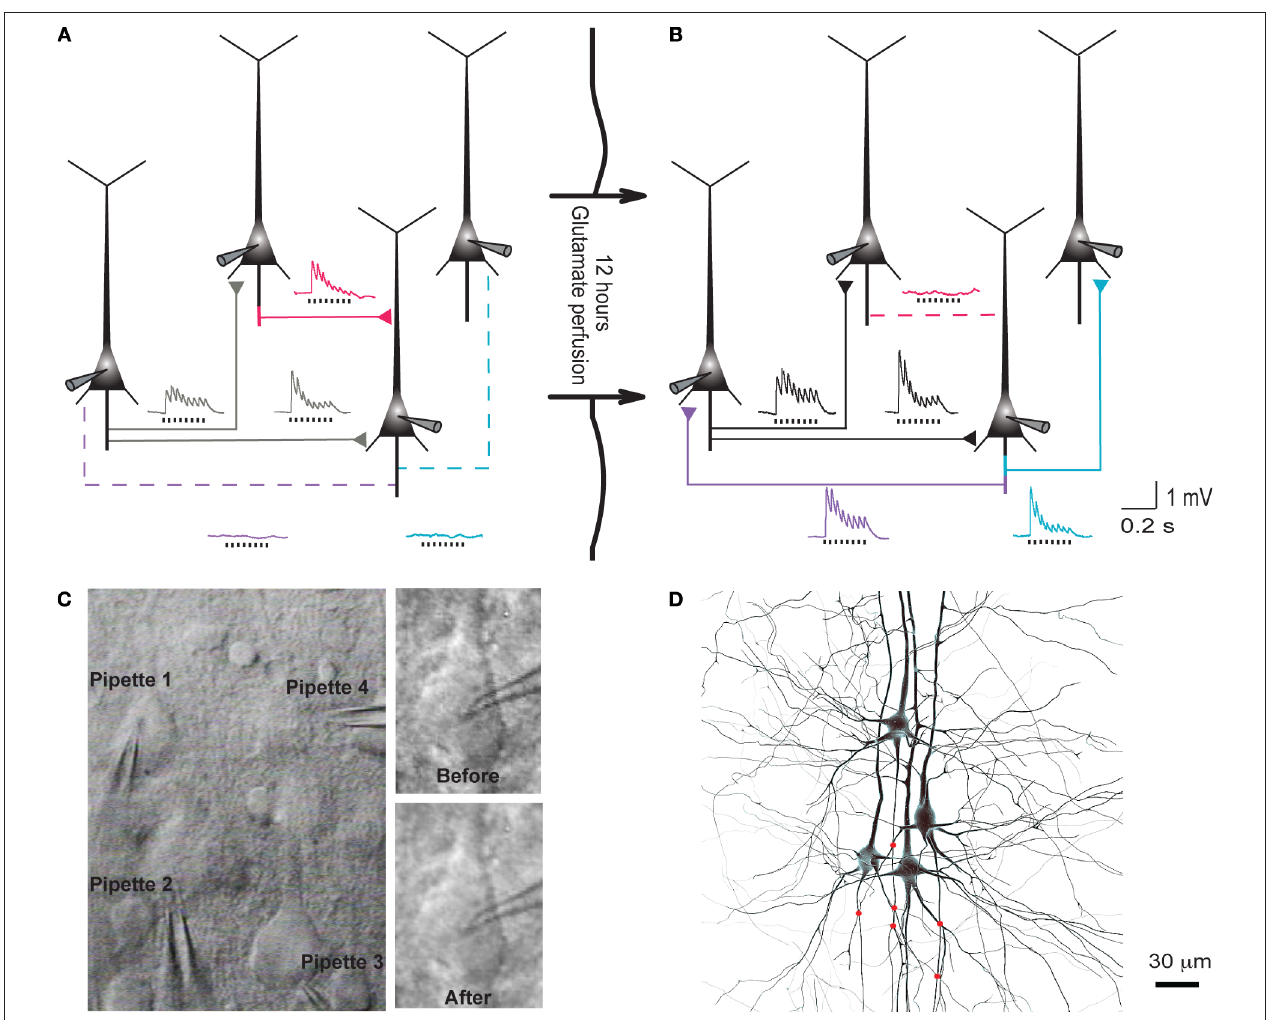
FIGURE 1 | Evoked emergence of connections following 12 h network stimulation. (A) Recording of layer 5 pyramidal cells (PC) using multiple whole- cell patch-clamp. Direct synaptic connections were examined by eliciting short trains of precisely timed action potentials at 30 Hz. (B) After 12 h of network stimulation by sodium glutamate. The red trace indicates a disappearance, blue and purple traces indicate emergences, grey and black traces indicate stable